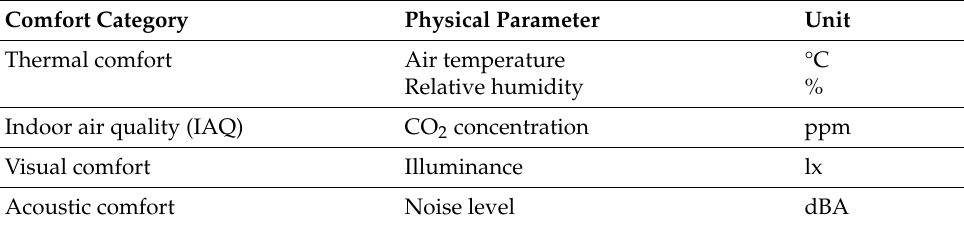
Table 1. Comfort categories and corresponding physical parameters and units. Comfort Category Physical Parameter Unit Thermal comfort Air temperature °C Relative humidity % Indoor air quality (IAQ) CO 2 concentration ppm Visual comfort Illuminance lx Acoustic comfort Noise level